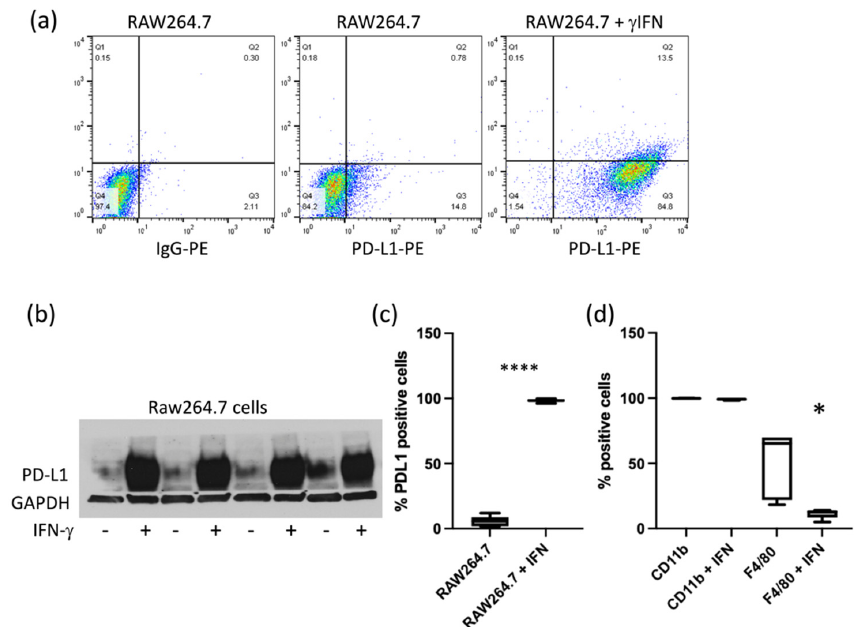
Figure 2. Representative dot plots of RAW264.7 cells without and with IFN- γ ( a ). Immunoblots of cell extracts showing the increase of PD-L1 with IFN- γ treatment ( b ). Percentage of PD-L1 positive RAW264.7 cells ( n = 7 without IFN, and n = 10 with IFN) (**** p < 0.0001) ( c ). Percentage of CD11b- ( n = 4) and F4/80- ( n = 5) positive RAW264.7 cells with and without IFN- γ (* p < 0.05) ( d